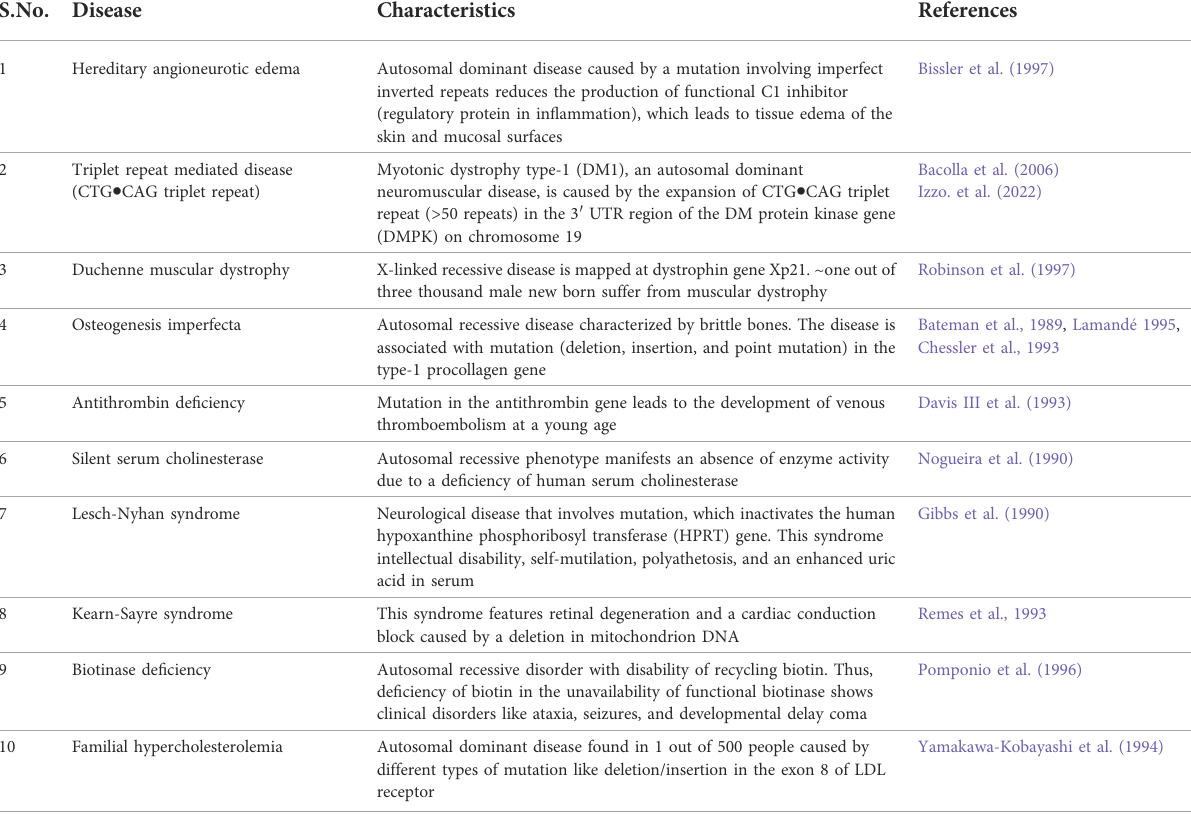
TABLE 1 Diseases associated with hairpin and cruciform